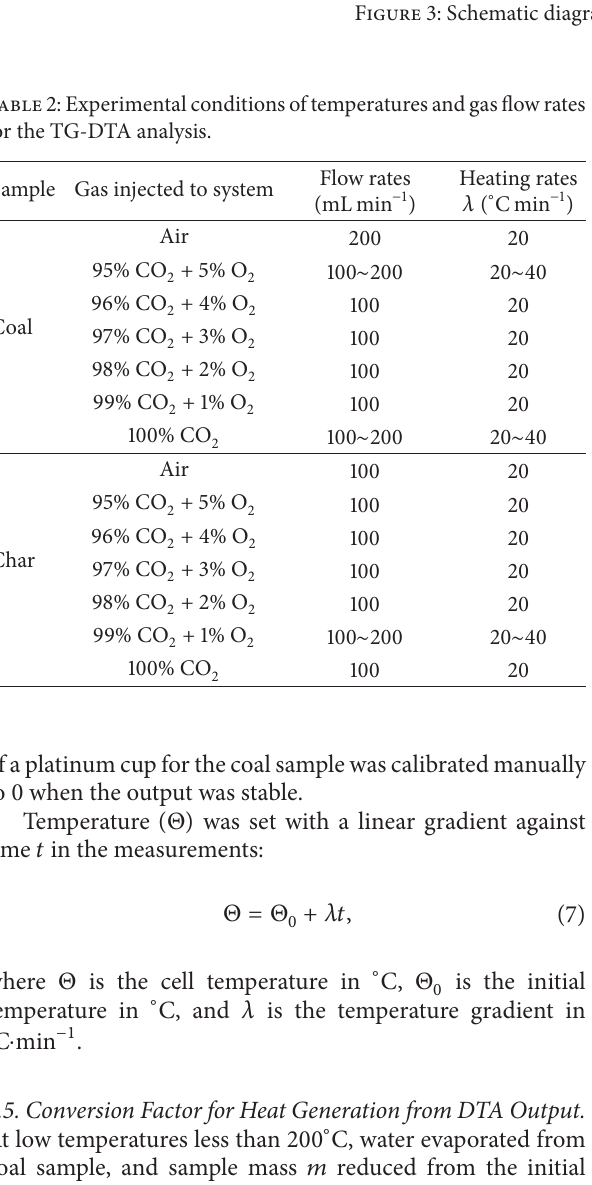
Figure 3: Schematic diagram of experimental apparatus.